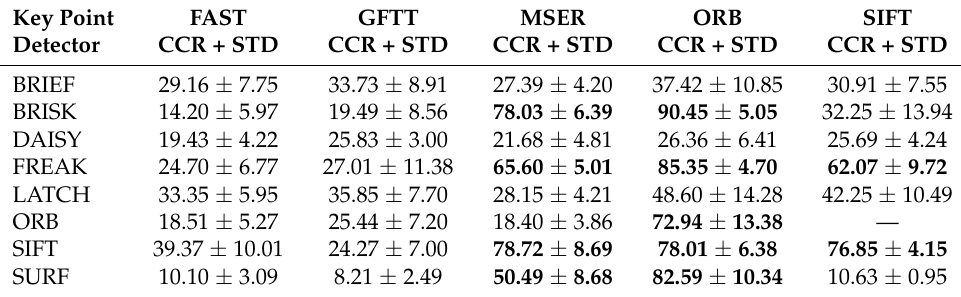
Table 4. Regime A: Evaluation of the method’s discriminative